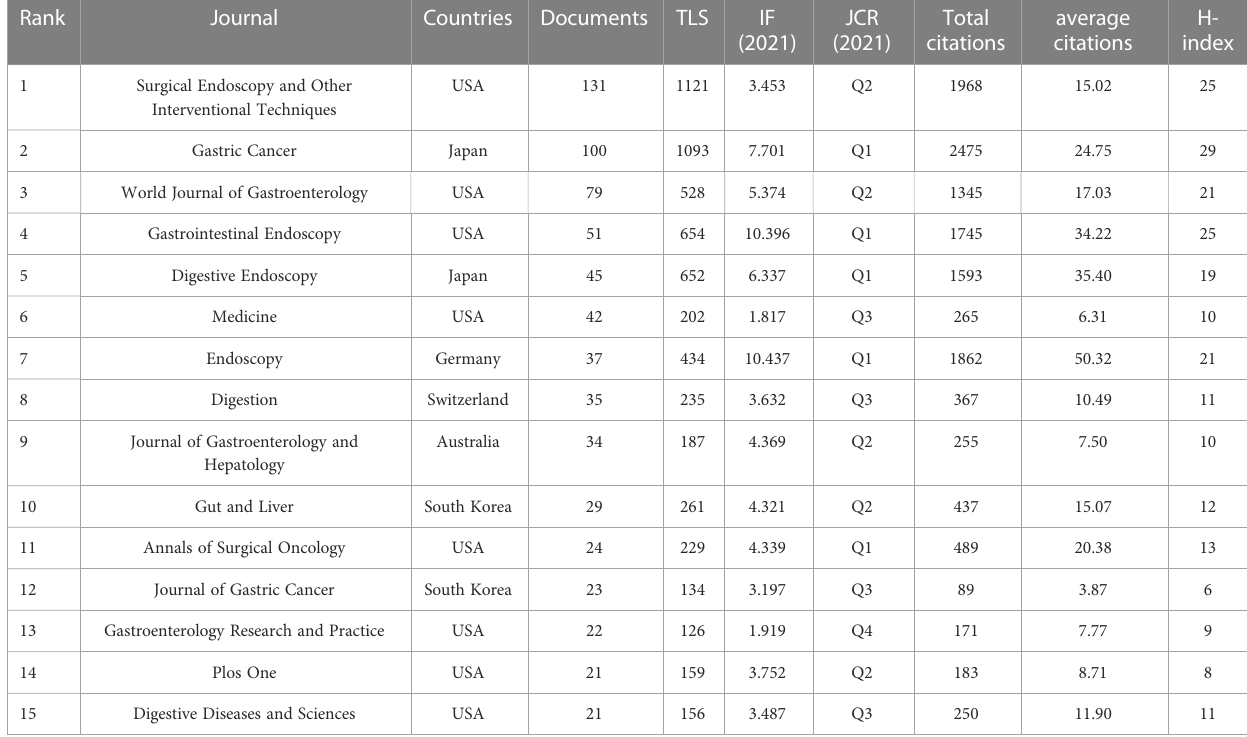
TABLE 2 The top 15 productive journals related to endoscopic application in early gastric cancer.